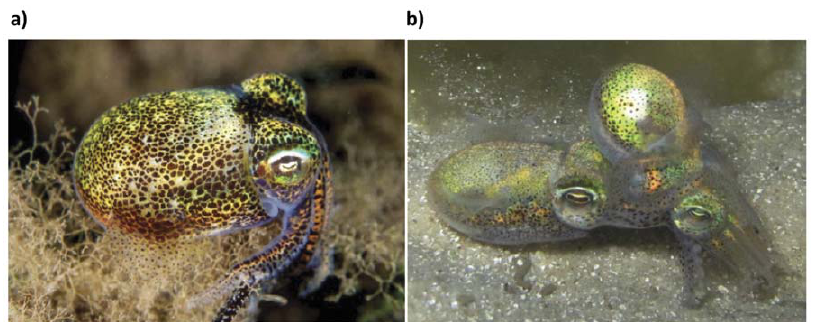
Figure 1. Photos of Euprymnatasmanica in the field. a) individual squid (photo: Mark Norman) b) mating pair (male left, photo: Zoe Squires).